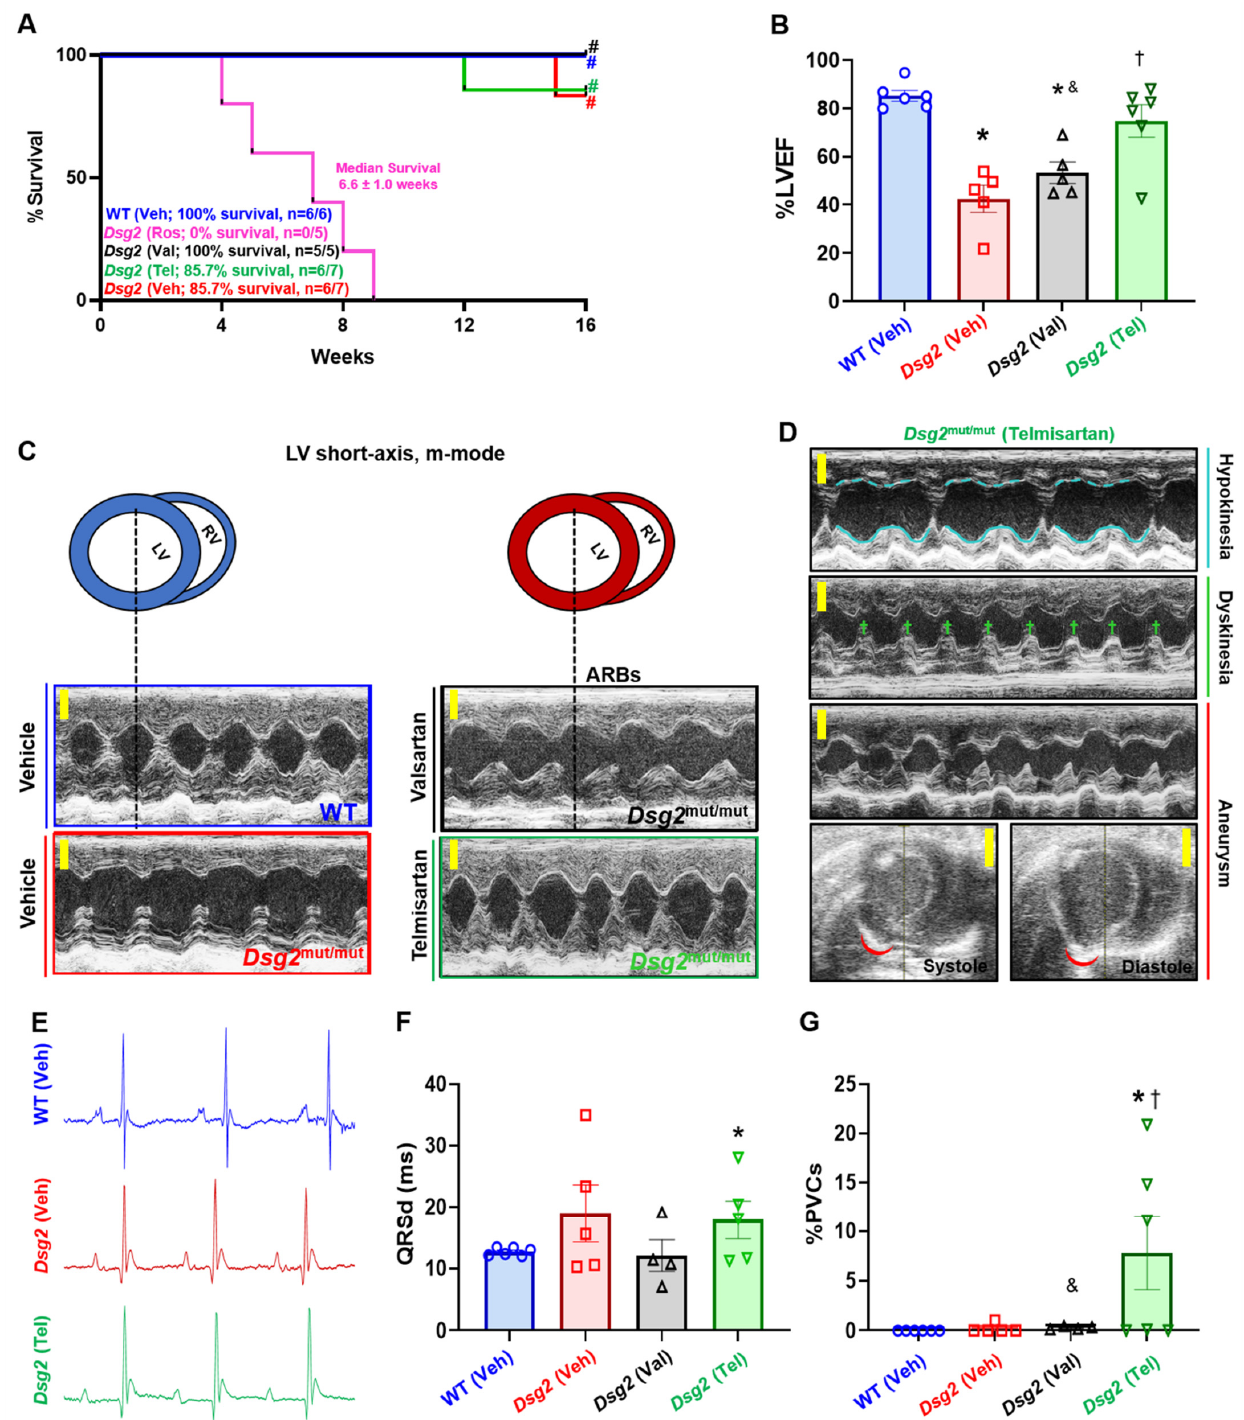
Figure 1. Survival and cardiac function in Dsg2 mut/mut mice treated with ARBs. ( A ) Percent survival. ( B ) Percent left ventricular ejection fraction (%LVEF). ( C ) Representative short-axis, m-mode echocardiograms from Vehicle- and ARB-treated cohorts. ( D ) Hypokinesis of the LV anterior wall